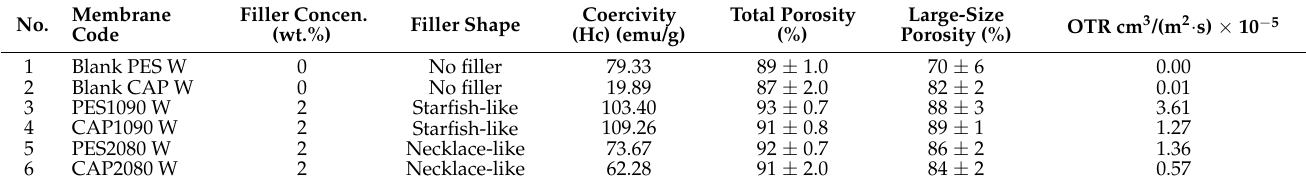
Table 5. Comparison between the magnetic mixed poly(ethersulfone) (PES) matrix [24] and the magnetic mixed cellulose acetate (CA)-matrix membranes regarding the coercivity (Hc), total and large-size porosity, and oxygen transmission rate